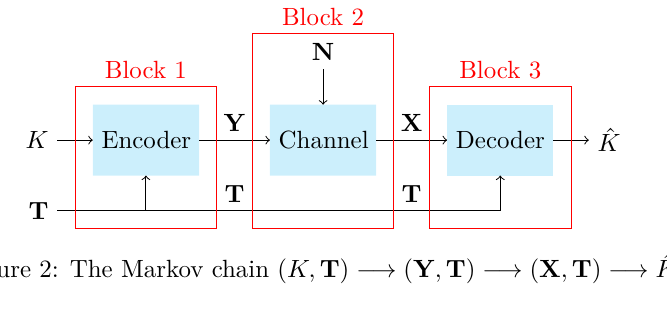
Figure 2: The Markov chain ( K, T ) −→ ( Y , T ) −→ ( X , T ) −→ ˆ K